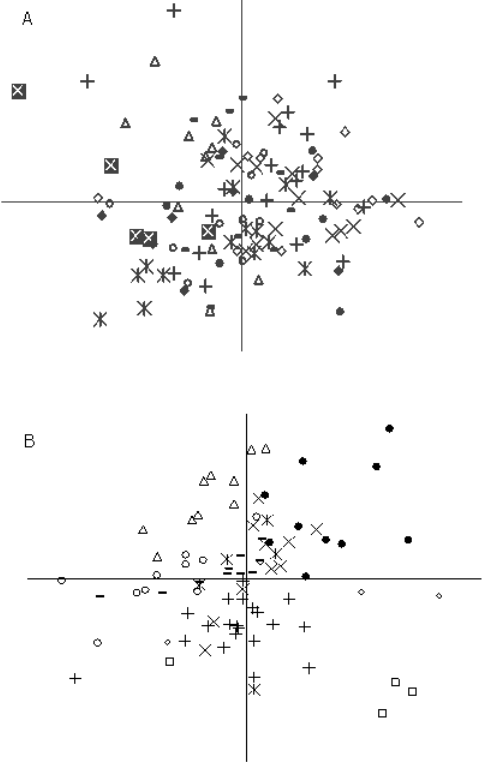
Figure 7 - Spatial representation of specimens of Lolliguncula brevis from Brazil as scored by the first two factors obtained from the Principal Component Analysis. Factor I, horizontal axis. Factor II, vertical axis. (A) Females; (B) Males;  Recife;  Bahia;  Rio de Janeiro;